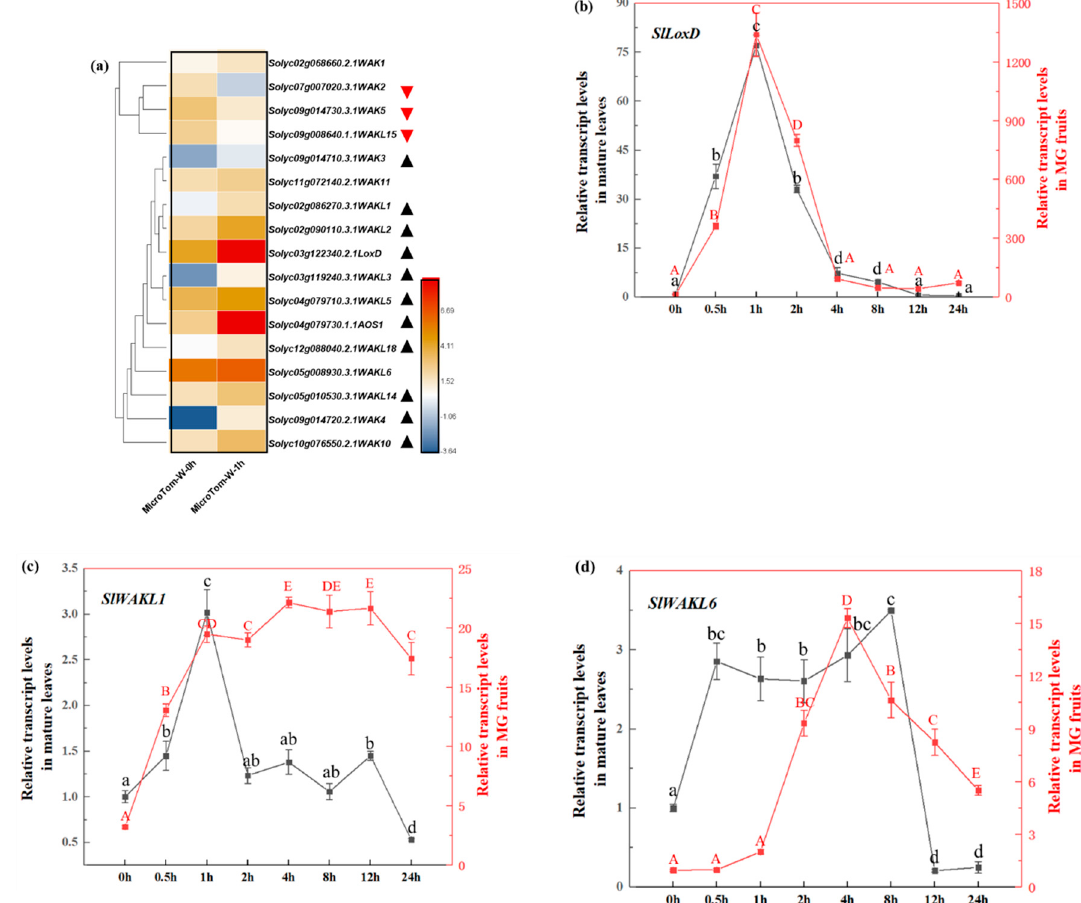
Figure 7. Expression analysis of SlWAK-RLKs in response to mechanical wounding. ( a ) Expression analysis of SlWAK-RLK genes in wounded mature leaf for 1 h. The RNA-seq expression data of various tissues/stages were used to reconstruct expression patterns of SlWAK-RLK genes. Excluding the RPKM 0 in any organs and stage. Relative expression values were transformed to log2(RPKM) represent relative expression levels. ▲ are used to marker the genes upregulated, and ▼ are used to marker the genes downregulated; ( b – d ) Time course transcript levels of SlLoxD , SlWAKL1 and SlWAKL6 in response to mechanical wounding in mature leaves and MG Fruits. The expression levels of the genes in mature leaves at 0 h are set to 1. Data are means ± SD ( n = 3). Letters above the bars indicate statistically significant difference ( p < 0.05).